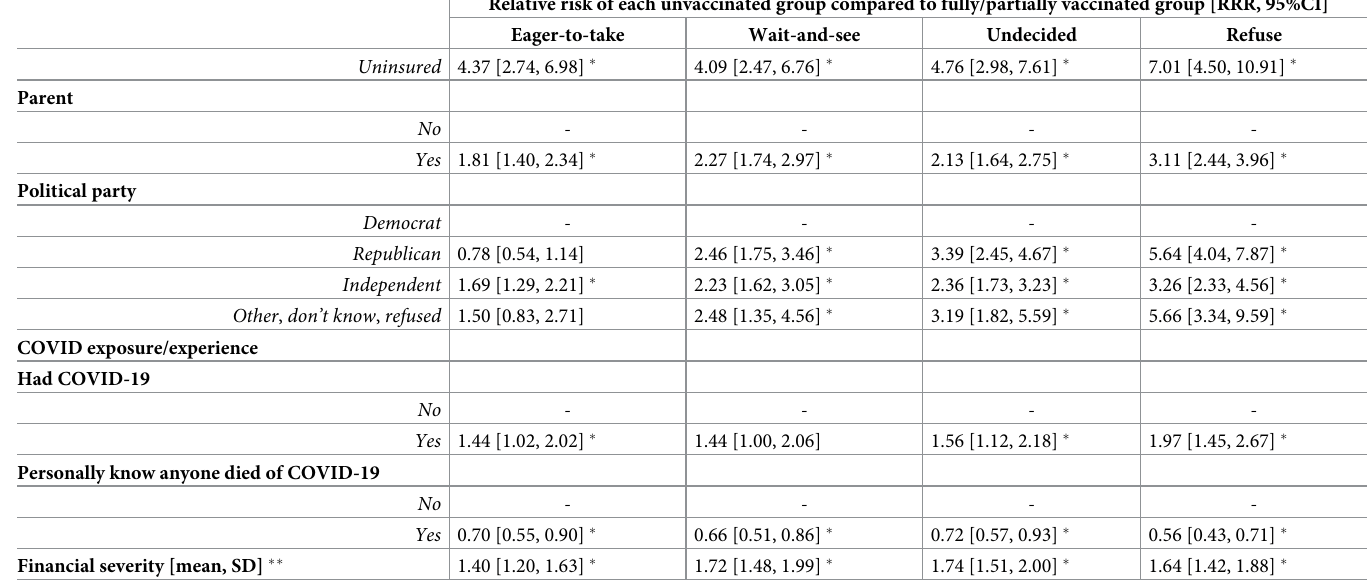
than Democrats to be in the wait [aRRR = 5.53, 95% CI:3.59–8.53 for Republicans, RRR = 3.04, 95% CI: 2.12–4.37 for Independent]. The higher the financial severity, the higher the risk of being in the wait group [aRRR = 1.23, 95%CI: 1.06–1.48]